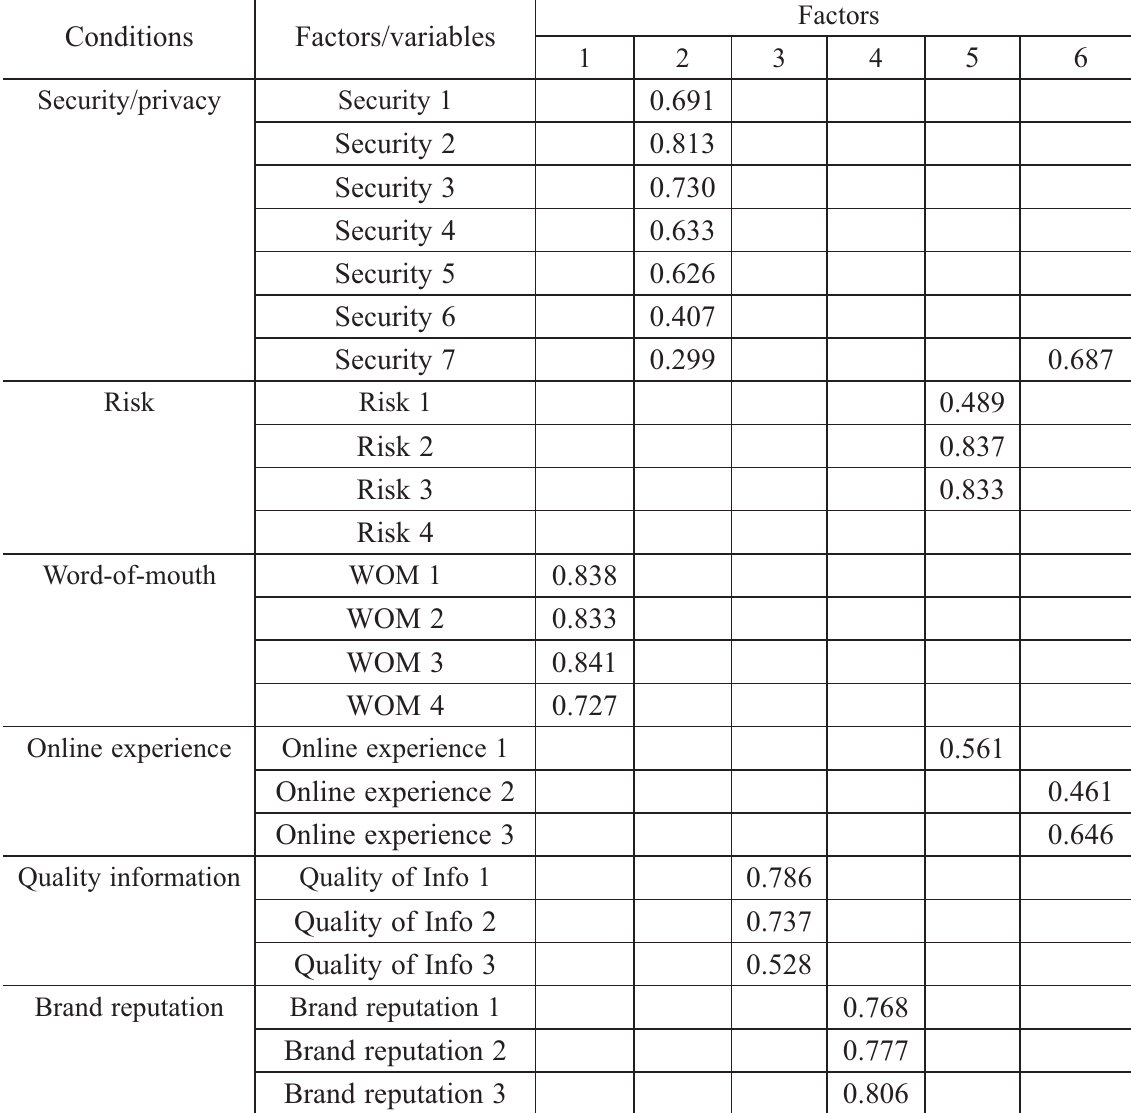
Table 3. Factor Analysis showing the combined impacts of the independent variables